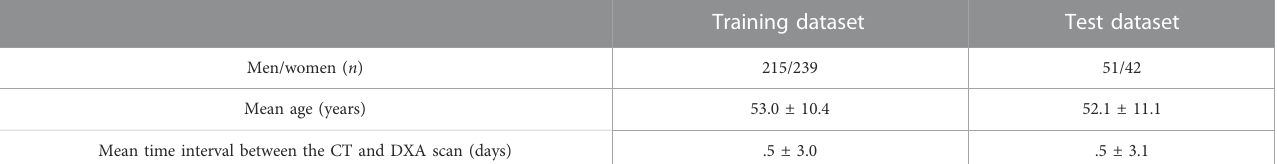
TABLE 1 Patient characteristics of training and test dataset. Each row means number of male/female patients, mean age and standard deviation, mean time interval between CT and DXA scans and standard deviation, respectively.